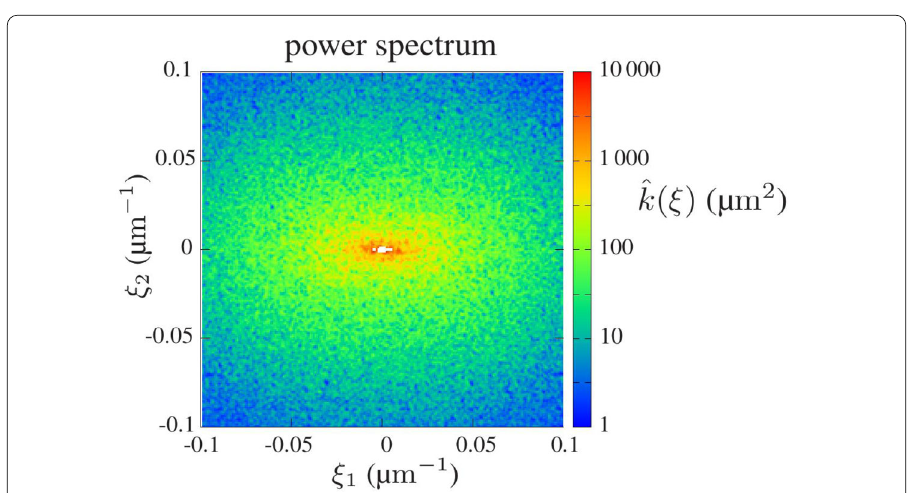
Figure 13 Estimate of the power spectrum ˆ k ( ξ ) of FL3 based on the image Fig.